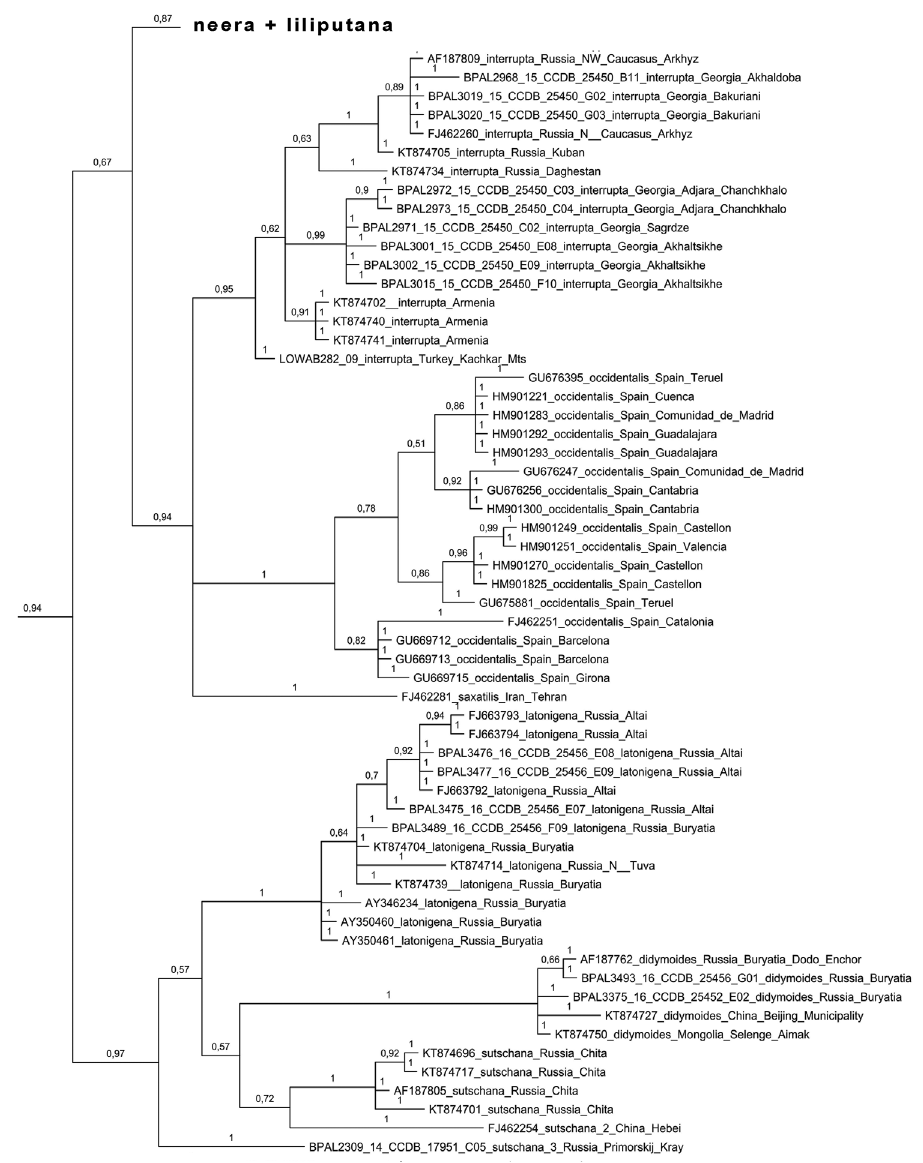
Figure 4. Fragment of the Bayesian tree of Melitaea didyma complex (haplogroups interrupta , occidentalis , saxatilis , lathonigena , didymoides , sutschana , sutschana 2 , sutschana 3 ) based on analysis of COI gene. Num- bers at nodes indicate Bayesian posterior